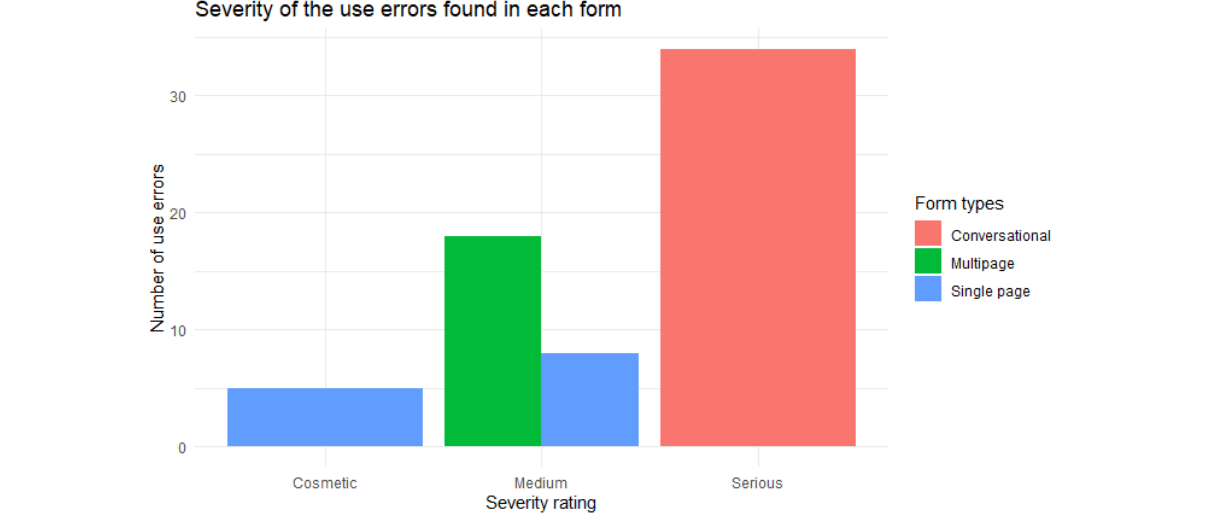
Figure 13. Bar graph for each form’s error severity. The multipage form errors were 69% medium errors, whereas the single-page form had only 31% medium errors and very few cosmetic